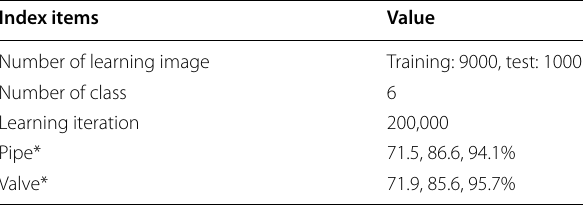
Table 1 Recognition performance of deep